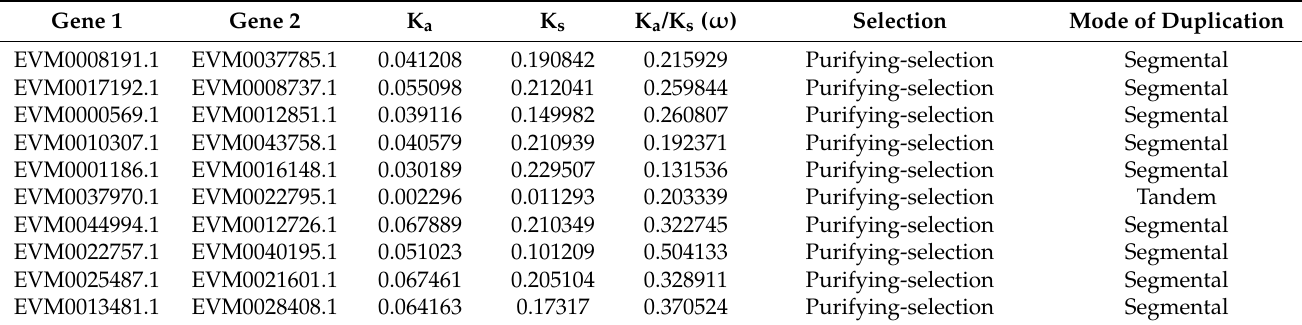
Table 3. K a (nonsynonymous)/K s (synonymous) ratio of WGD/segmental duplicated EjALMT genes. Gene